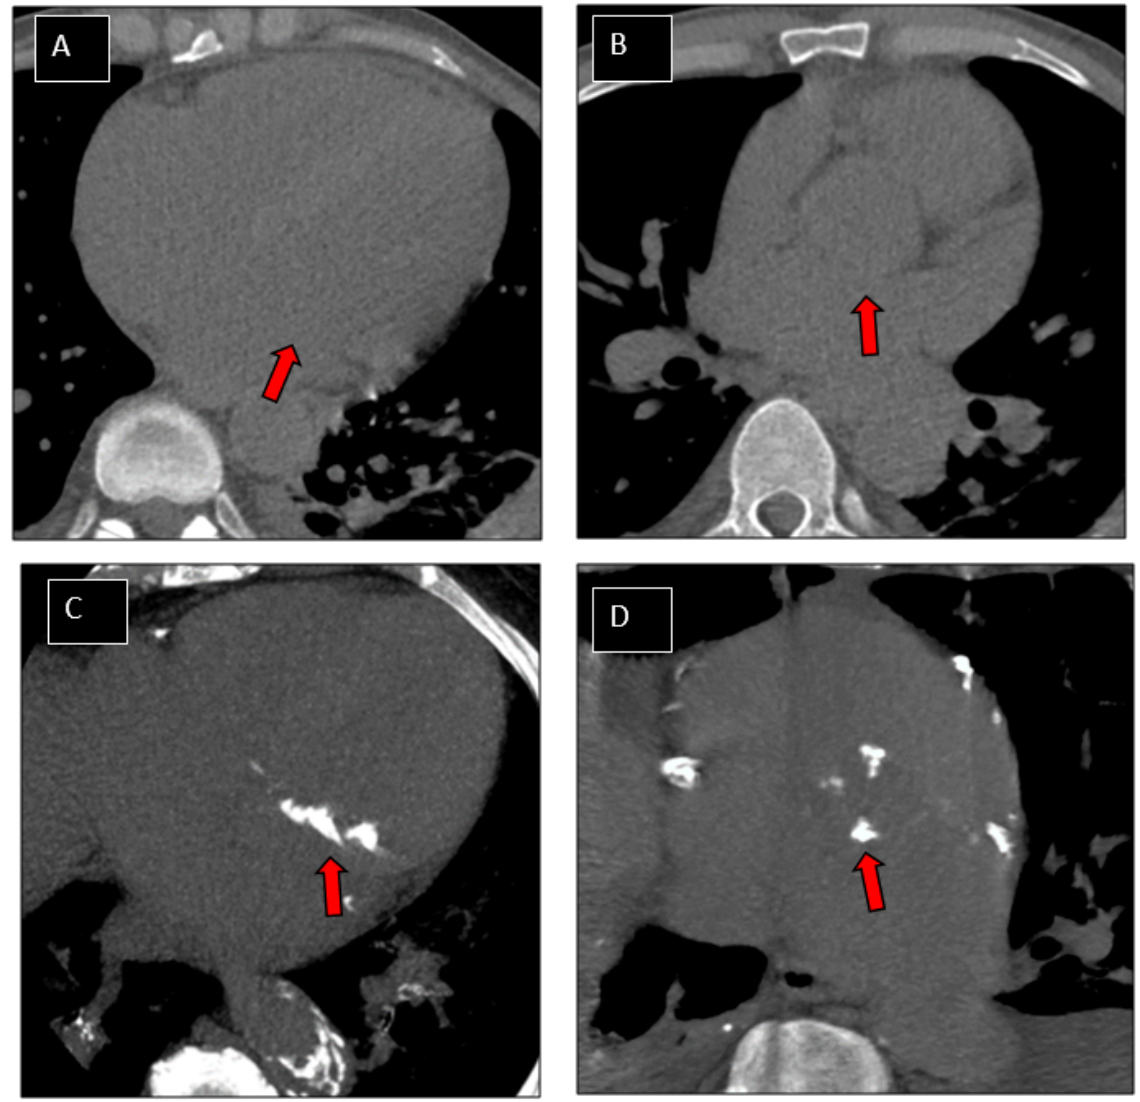
Figure 3. Patterns of patients. Examples of patterns of valve calcifications on CT images. Non-calcified mitral ( A ; arrow) and aortic ( B ; arrow) valves. Valve calcium scores (VCS) were equal to 0 for both valves. Highly calcified mitral ( C ; arrow) and aortic ( D ; arrow) valves. VCS were 1247 and 1080, respectively for mitral and aortic valve.